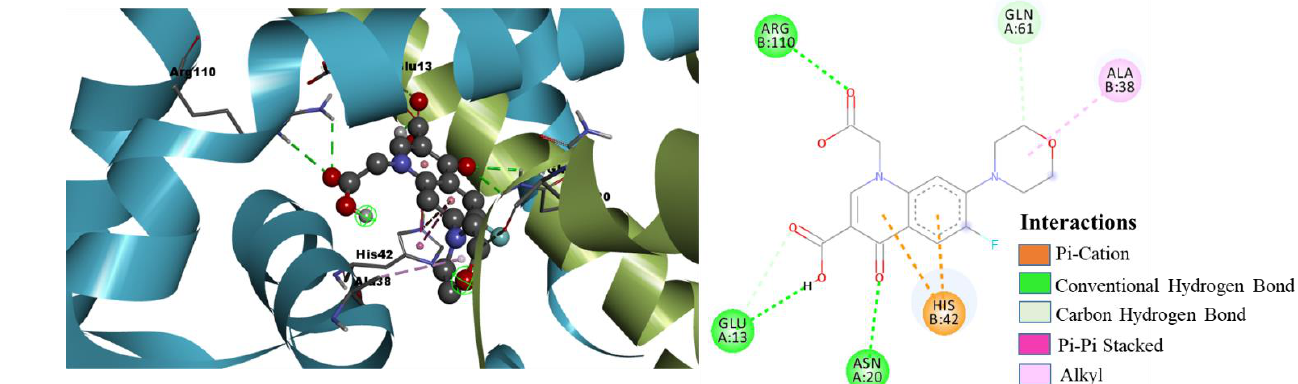
Figure 8. Binding mode conformation and molecular interactions of compound 7a in the active site of S. epidermidis TcaR. The left and right figures represent the molecular interactions in 3D and 2D, respectively. The compound 7a is shown in the ball-stick model, and the key interacting residues are shown as grey sticks.